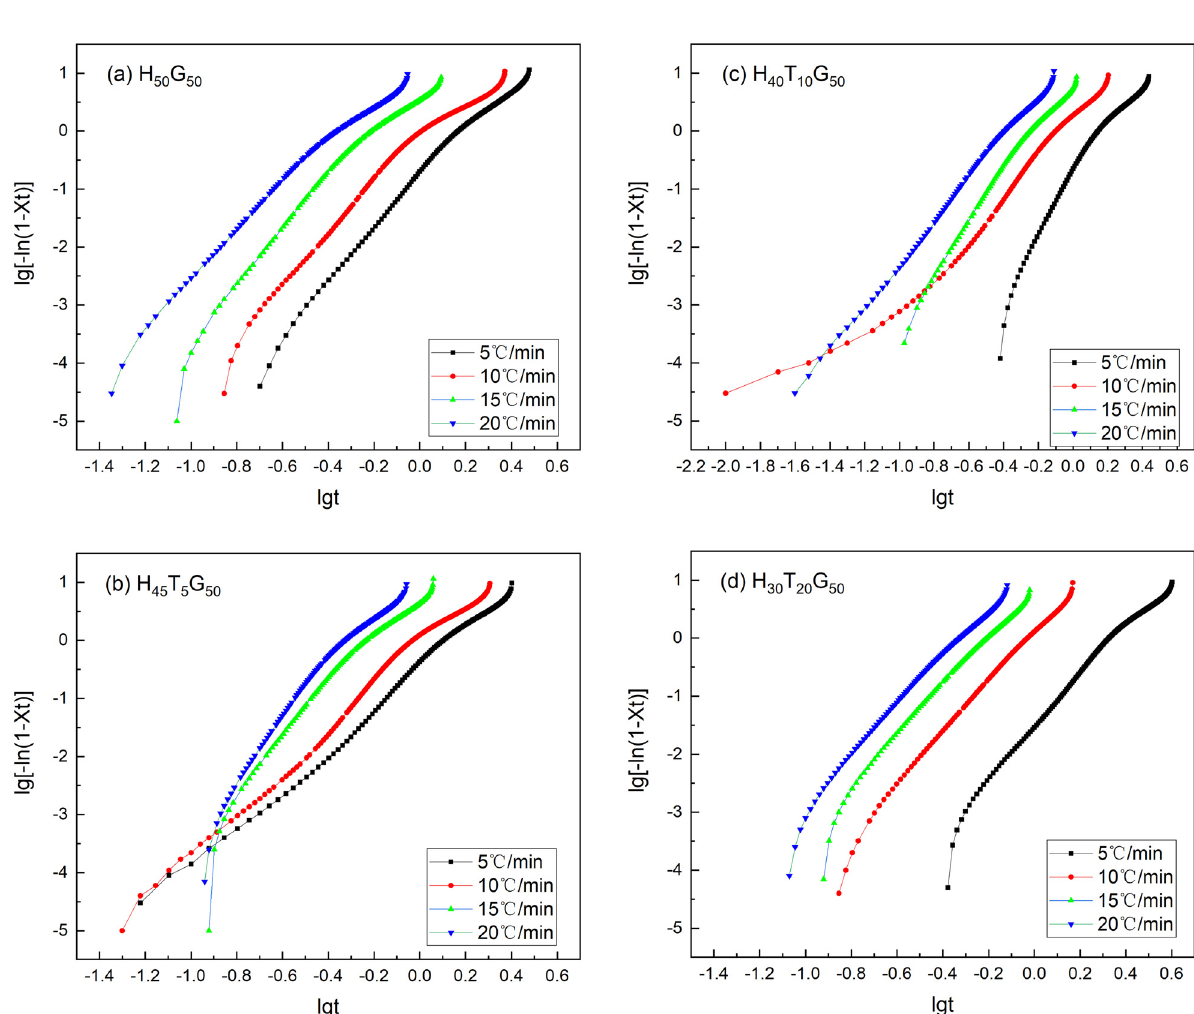
Figure 4: Avrami plots for H 50 G 50 ( a ) , H 45 T 5 G 50 ( b ) , H 40 T 10 G 50 ( c ) , and H 30 T 20 G 50 ( d )